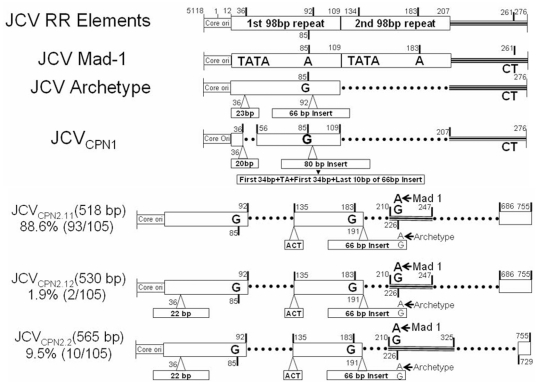
Comparison of different kinds of organization of JCV regulatory regions.Comparison of the regulatory regions (RR) of JCV prototype Mad-1, JCV archetype, JCVCPN1 and the JCVCPN2 subtypes.